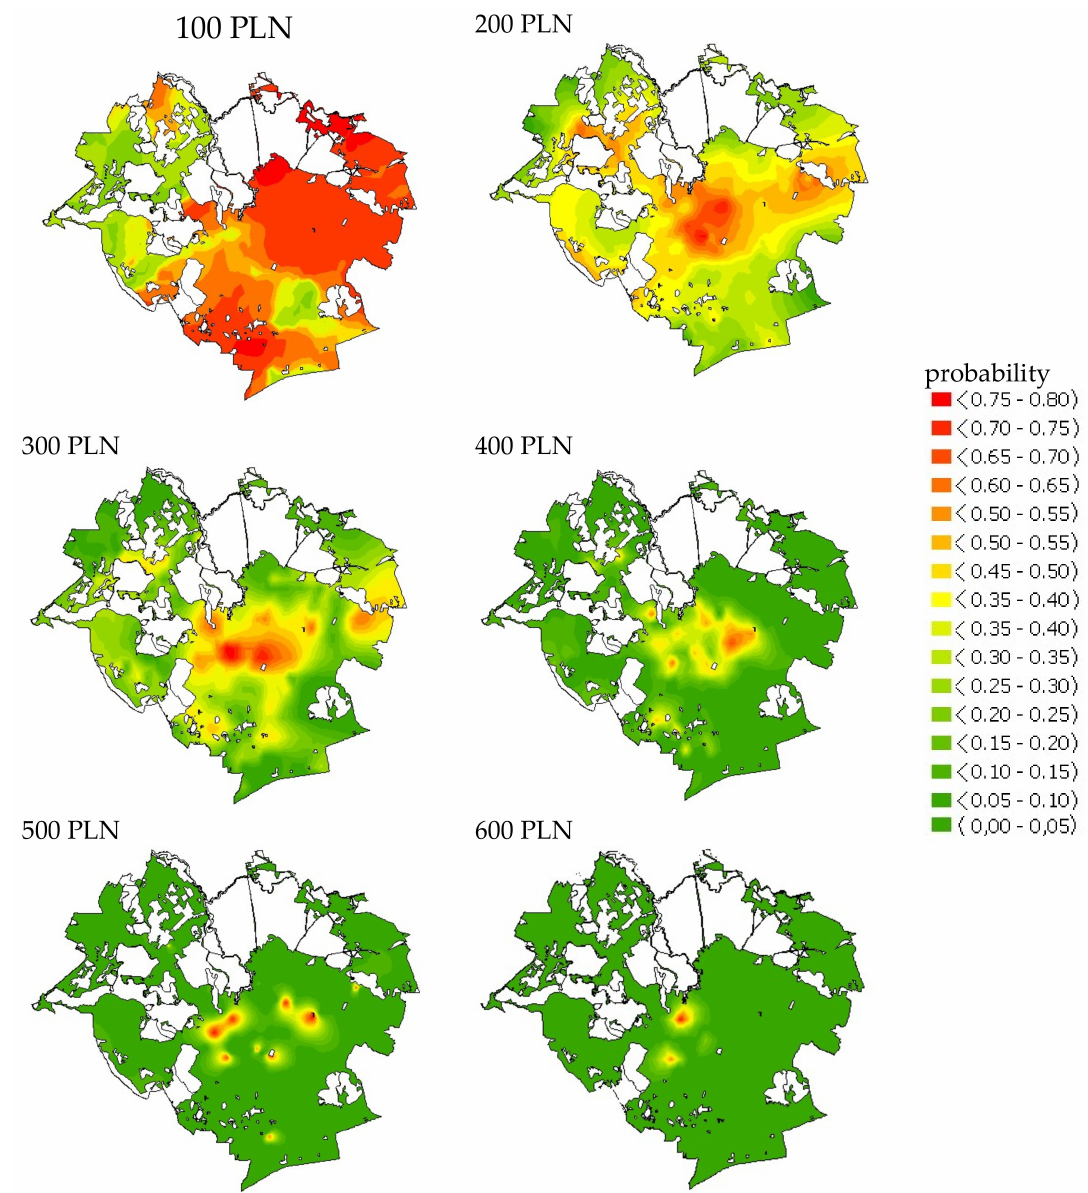
Figure 10. Probability maps of prices above specific